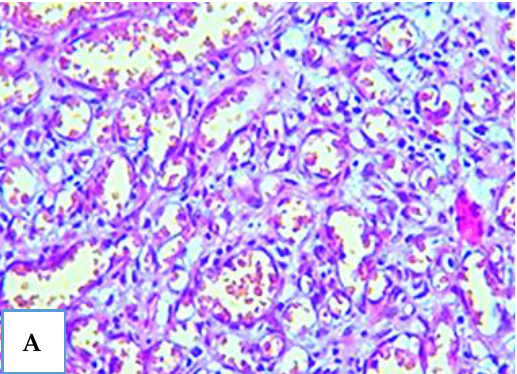
B Figure (3-B): Photomicrograph lobular PG 40x